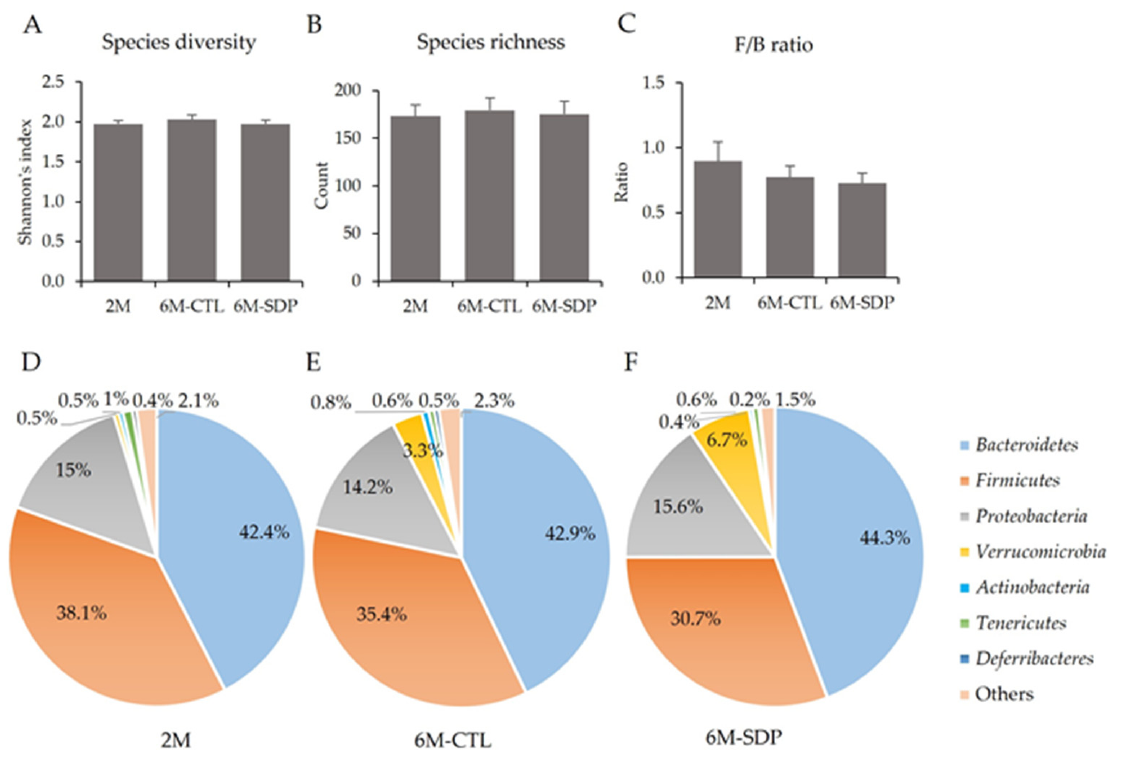
Figure 8. Microbial Shannon’s index ( A ), species richness ( B ), ratio between Firmicutes / Bacteroidetes (F/B) ( C ), and bacterial composition at the phylum level in the 2M group ( D ), 6M-CTL group ( E ), and 6M-SDP group ( F ). Results are expressed as mean ± SEM and as percentages ( n = 10–11 mice/group). Statistics: ANOVA (Benjamini and Hochberg multiple comparison test).